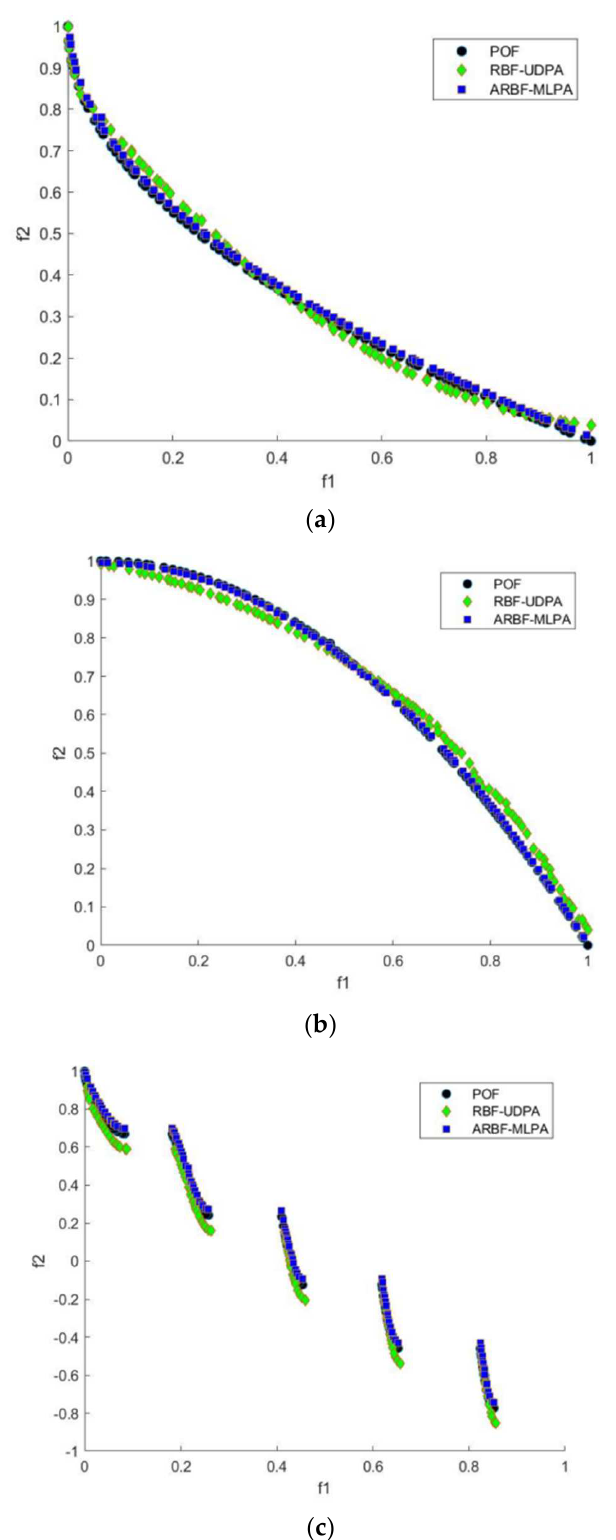
Figure 7. ( a ) Front comparison under function ZDT1. ( b ) Front comparison under function ZDT2. ( c ) Front comparison under function ZDT3.